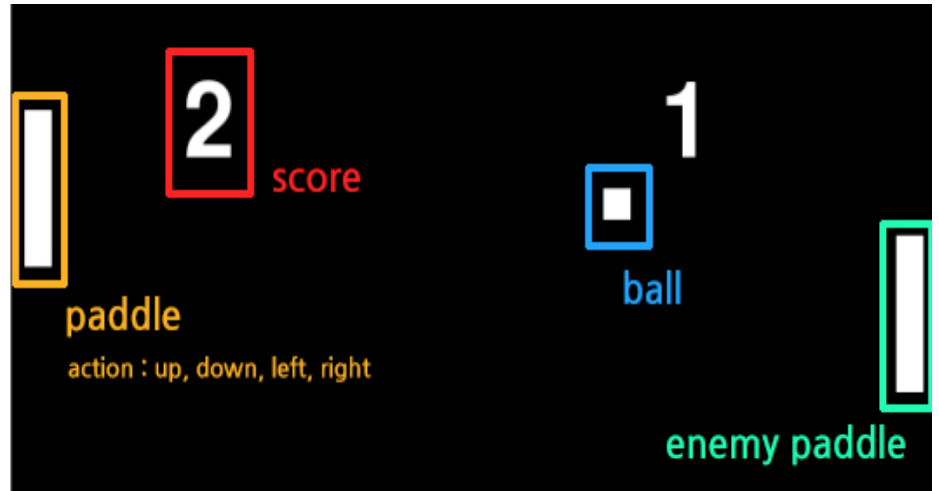
Figure 3. The ping-pong game implemented through Python. Table 2. Basic rules of the ping-pong game.